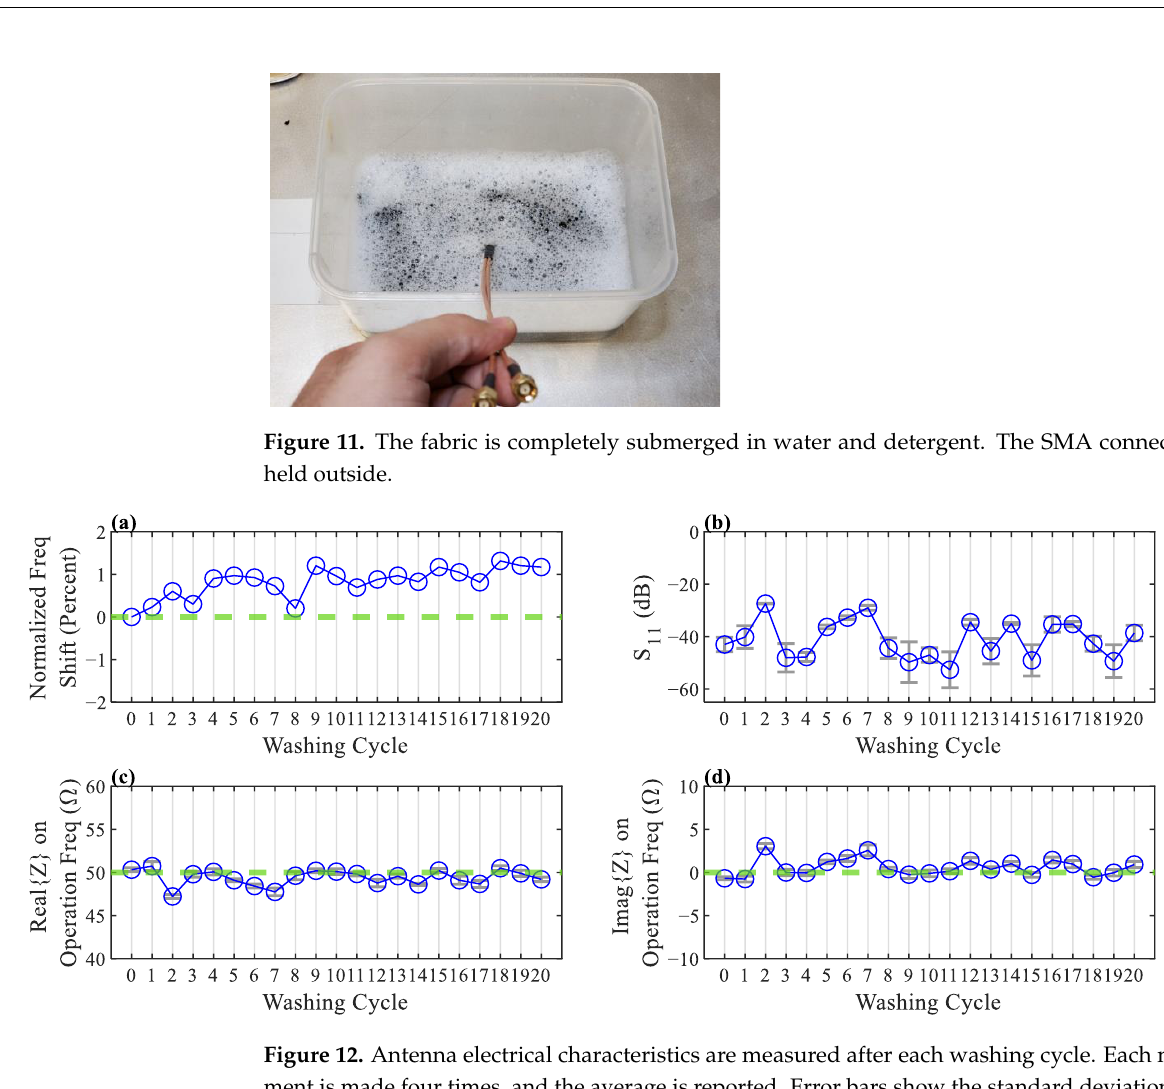
12 of 20 Figure 10. A 50 Ω antenna sensor 𝑛 = 5 , embedded on a smart T-shirt for vital signal monitoring applications. 5.3. The Durability of the Antenna Sensor An experiment is performed in order to demonstrate the durability of the conductive polymer material for wearable smart textile applications intended for everyday use. A 50 Ω antenna sensor is fabricated and sewn on a piece of fabric, and its electrical specifi- cations are measured. The fabric and the antenna sensor are washed for 20 cycles, and the measurements are performed again after each cycle. During each step, the fabric is submerged in a container filled with tap water and detergent and is stirred vigorously to simulate a washing procedure. The fabric is taken out after 5 min, and then it is rinsed using tap water. Next, a piece of a napkin is used to remove the excessive wetness of the fabric. Finally, a heat gun is used for 10 to 15 min to completely dry out the fabric and antenna sensor. The specifications of the antenna sensor